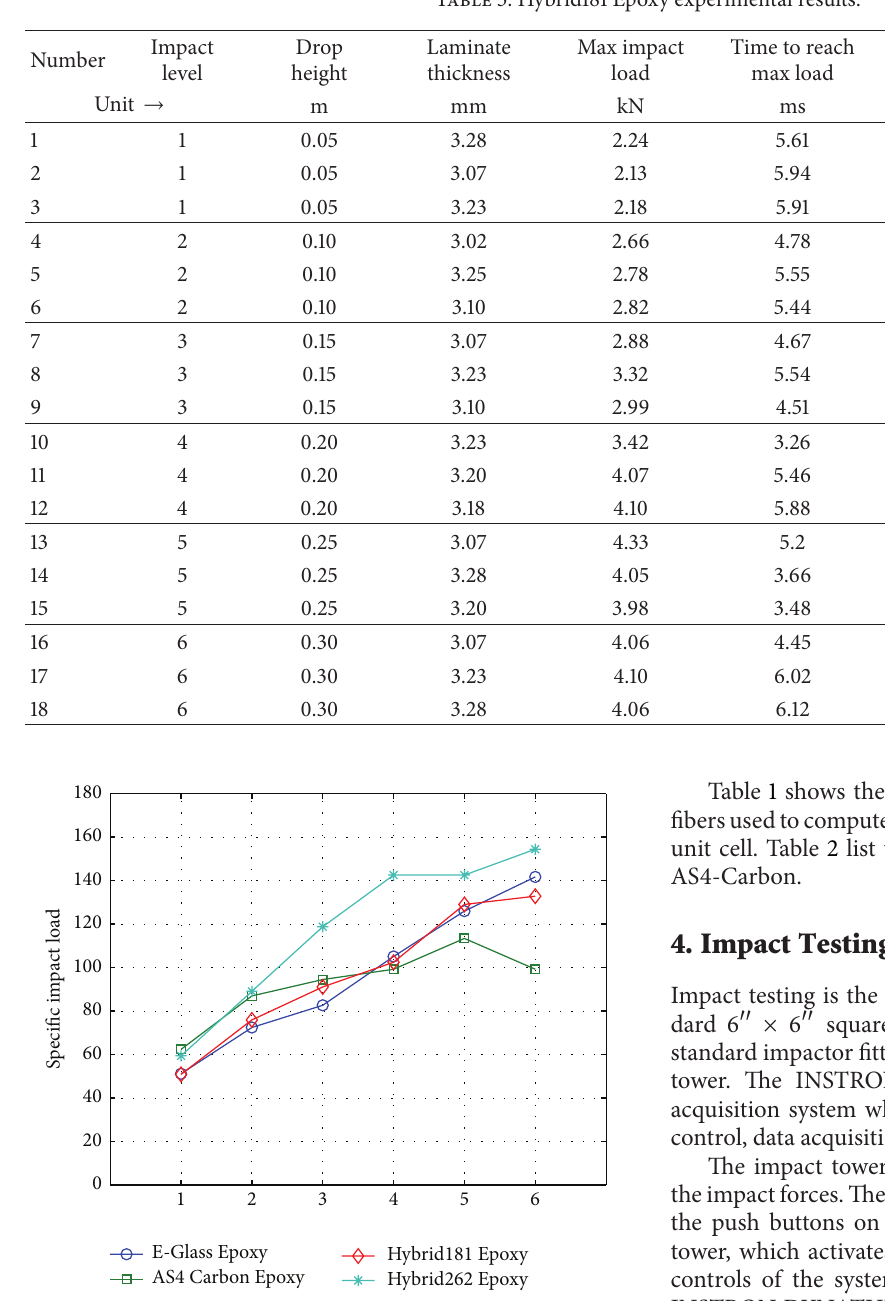
Table 5: Hybrid181 Epoxy experimental results.